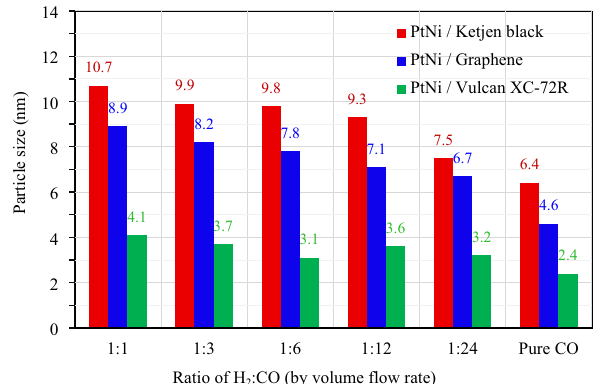
Figure 2. The average particle size of Pt 3 Ni/C nanoparticles prepared with different H 2 :CO volume flow rate (cm 3 min −1 ) i.e., 60:60 (1:1), 30:90 (1:3), 20:120 (1:6), 10:120 (1:12), 5:120 (1:24) and pure CO,